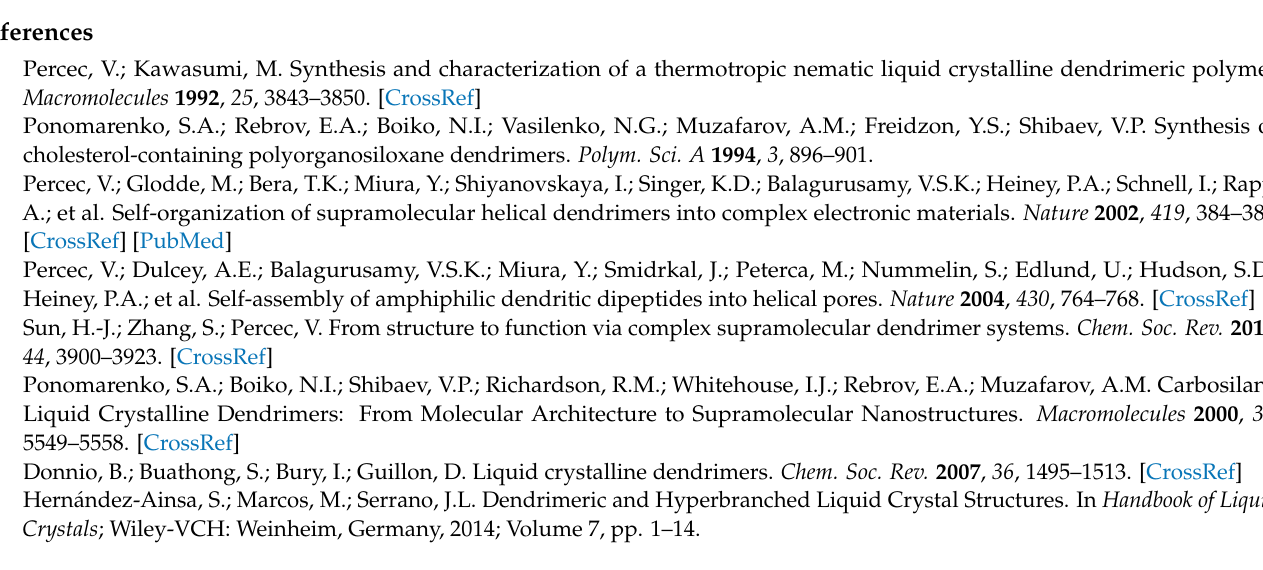
spectra (continuous lines, absorbance in arbitrary units, u.a.) and fluorescence emission (dashed lines, intensity in u.a.) for the alkynyl dendrons. HPLC-grade DCM was used as the solvent in both studies, Figure S11: 1H NMR spectrum of AuDT in DCM-d2 solution at 25 ◦ C, Figure S12: 1H NMR spectrum of AuDT-AT in DCM-d2 solution at 25 ◦ C, Figure S13: 1H NMR spectrum of AuDT-TA@L2-3,4 in DCM-d2 solution at 25 ◦ C, Figure S14: 1H NMR spectrum of AuDT-TA@L3-3,4,5 in DCM-d2 solution at 25 ◦ C, Figure S15: 1H NMR spectrum of AuDT-TA@L4-3,4 in DCM-d2 solution at 25 ◦ C, Figure S16: 1H NMR spectrum of AuDT-TA@L4-3,5 in DCM-d2 solution at 25 ◦ C, Figure S17: 1H NMR spectrum of AuDT -TA@L6-3,4,5 in DCM-d2 solution at 25 ◦ C, Figure S18: 1H NMR spectrum of AuDT-TA@L9-3,4,5 in DCM-d2 solution at 25 ◦ C, Figure S19: Fluorescence emission spectra of alkynyl dendrons (dashed lines) and dendrons incorporated into NP ´ s by cycloaddition (solid lines). HPLC-grade DCM was used as the solvent, Figure S20: Survey XPS spectrum of AuDT-TA@L3-3,4,5 at 0 min treatment thermic time, Figure S21: Photographs and histograms obtained by TEM at 200 kV for AuDT-TA@L2-3,4 samples after 180 minutes of treatment at 120 ◦ C (100 nm scale) and 180 ◦ C (500 nm scale). The TEM photographs and histograms obtained after treatment at 150 ◦ C are included in Figure 5 of the main text, Figure S22: Growths of the nanoparticle mean diameters Φ (in nm) versus the reaction time (in min) at isotherms of 120, 150 and 180 ◦ C for the AuDT-TA@L2-3,4 particles obtained by cycloaddition, Table S1: X-Ray diffraction data of alkyne focal-point ligands, Table S2: UV-Vis absorption and emission data of alkyne-focal point dendrons, Table S3: Absorption and emission values of the AuDT-AT-TA@Ln nanoparticles in DCM solution, Table S4: XPS data